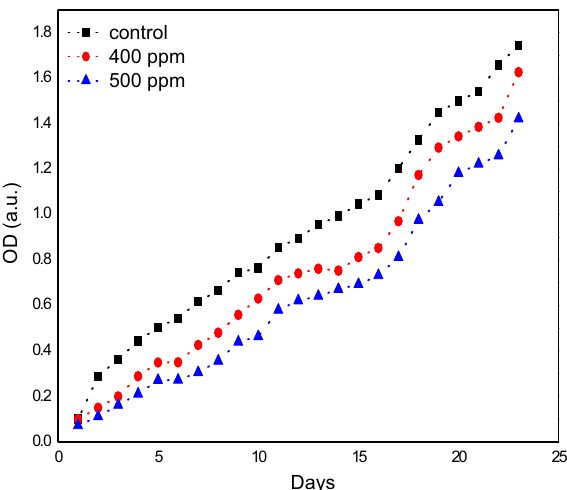
Figure 9. Growth curves of F. oxysporum (F.o) at different concentrations of NAFO nanoparticles added at the logarithmic phase. F. oxysporum grown without NAFO served as control.